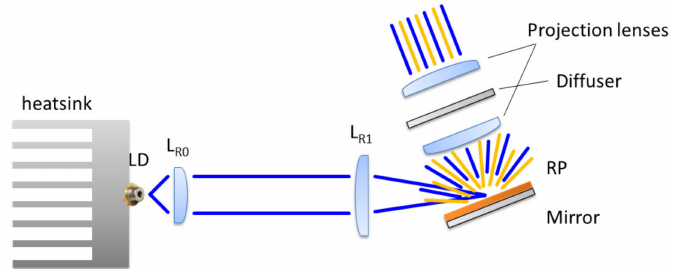
Figure 15. Schematic structure of the reflected LARP setup nr. 1.